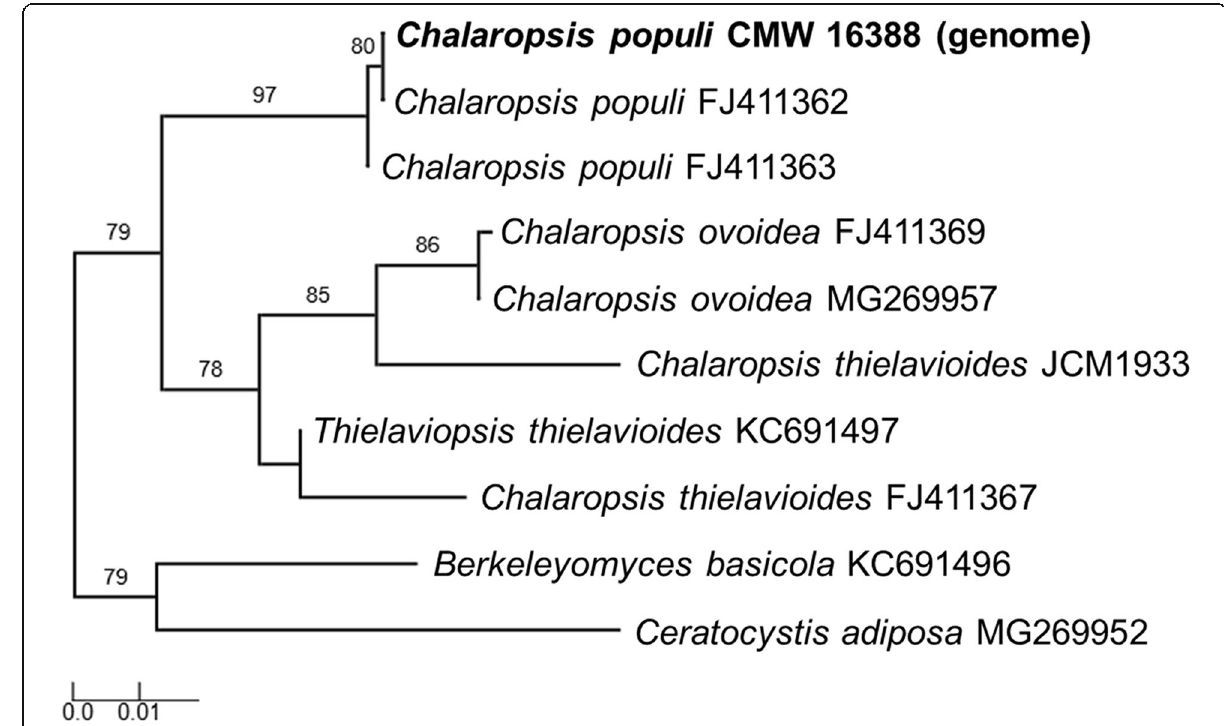
Fig. 3 A Maximum Likelihood phylogeny based on the beta-tubulin gene from species of Chalaropsis . This analysis confirms the identity of the genome assembly presented here (shown in bold) as Chalaropsis populi . Interestingly, the publicly available Ch. thielavioides JCM 1933 genome (Genbank accession: GCA_001599435) grouped in the same clade as Ch. ovoidea . Ceratocystis adiposa and Berkeleyomyces basicola were used as outgroups, and the results for the approximate likelihood ratio test for branch support are shown as